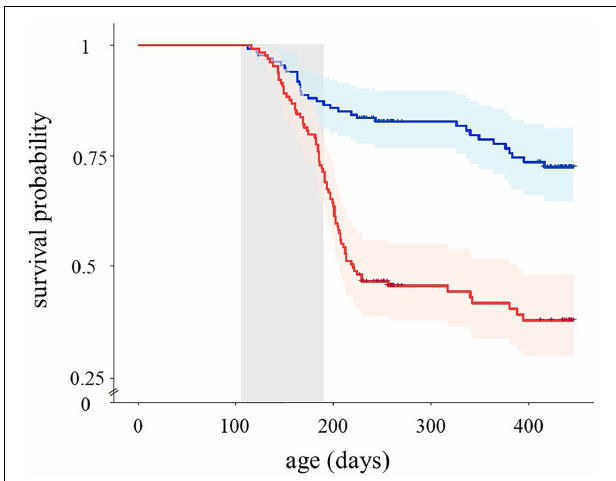
FIGURE 3 | Estimated survival functions of sticklebacks reared in the learning task (red line, n = 130) and control treatments (blue line, n = 134) during the study. Gray shadow indicates the period of the experimental treatment. Crosses mark censorship events, i.e., individuals sampled for the brain analyses and those still alive at the end of the monitoring